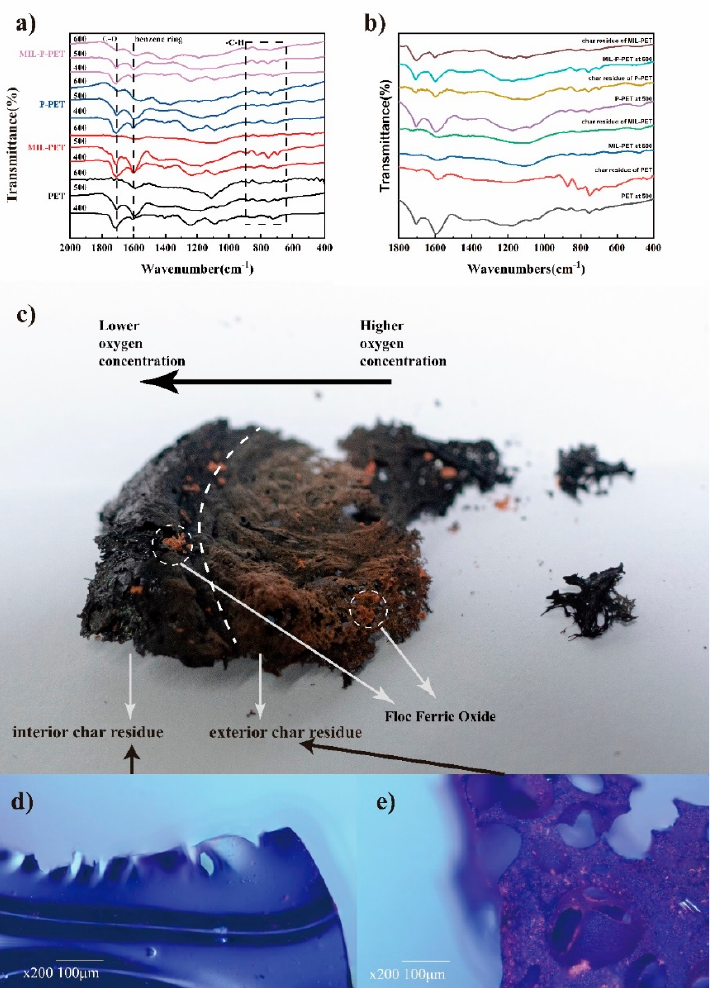
Figure 9. FTIR spectra of the char residue of PET composites at various constant temperatures ( a ). ( b ) Comparison between CC test and muffle furnace. ( c ) Digital photo of MIL − PET at 600 °C. Optical microscope images of ( d ) interior and ( e ) exterior char residue.